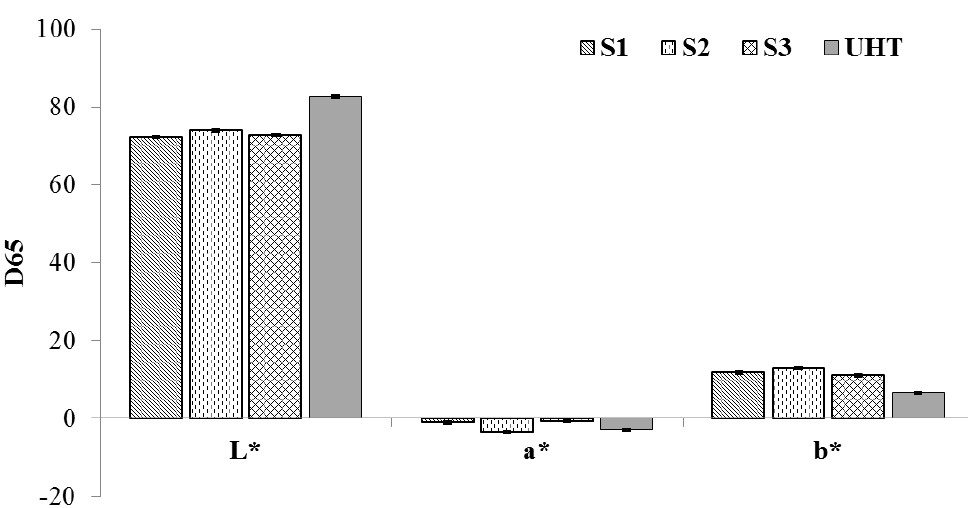
Figure 1. Color parameters of soy-based beverages and UHT cow milk.